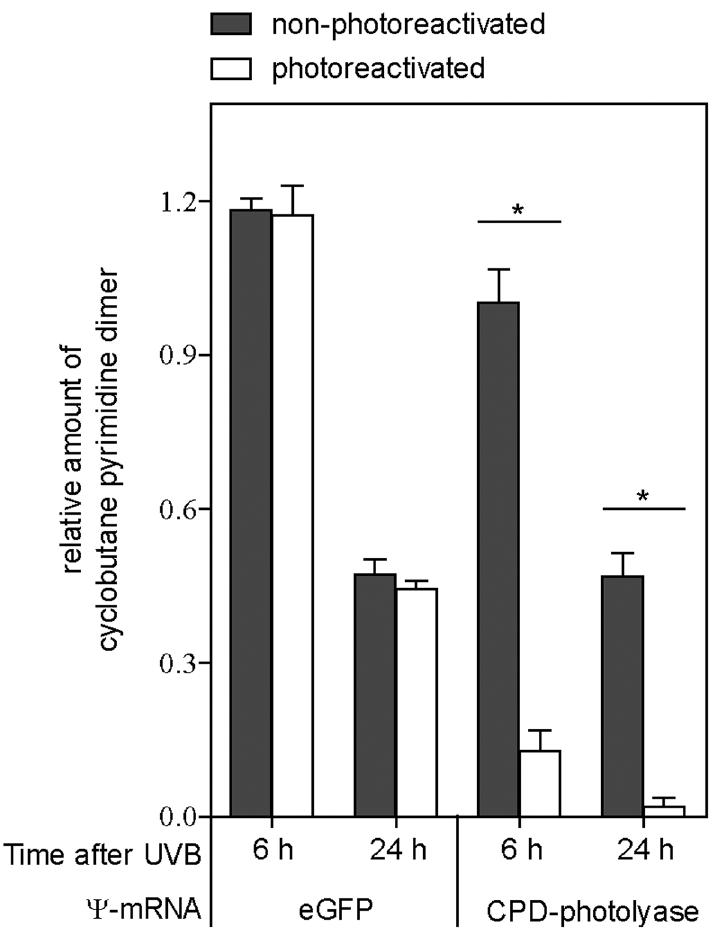
Fig 1. Accelerated photorepair of CPDs in HaCaT cells transfected with CPD-PL Ψ -mRNA. HaCaT cells were transfected with lipofectamine-complexed Ψ -mRNA encoding CPD-photolyase. Twelve hours later, cells were subjected to 20 mJ/cm 2 UVB and immediately exposed to photoreactivating light (photoreactivated) or left in the dark (non-photoreactivated) for 1 h and then maintained at 37°C for 5 and 23 hs. After incubation at 5 and 23 h, genomic DNA was isolated at the indicated times after UVB irradiation and the amount of CPDs was measured by ELISA. The values were calculated relative to those obtained with cells that were not UVB- irradiated. Significance was assessed by unpaired, two-sample t -test, p < 0.05. Error bars represent the standard error of the mean from three experiments performed